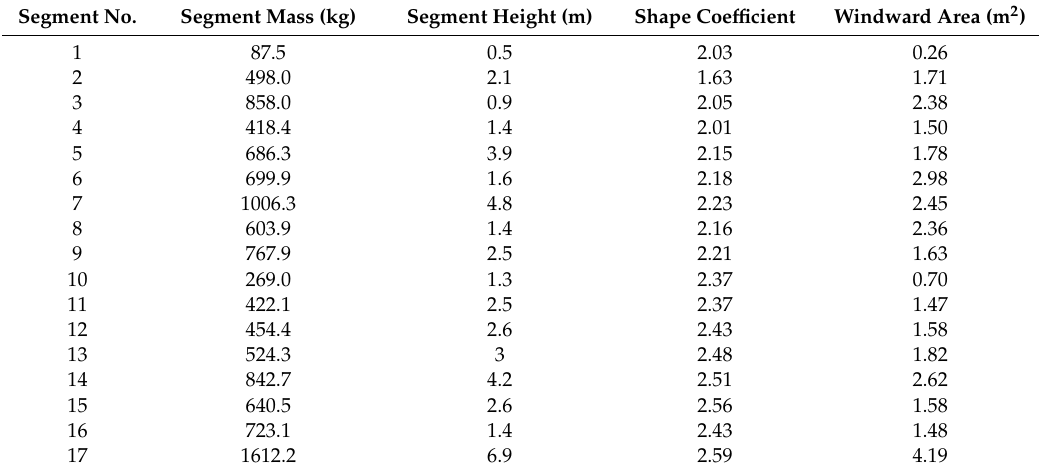
Table 5. Segment parameters of the prototype tower.